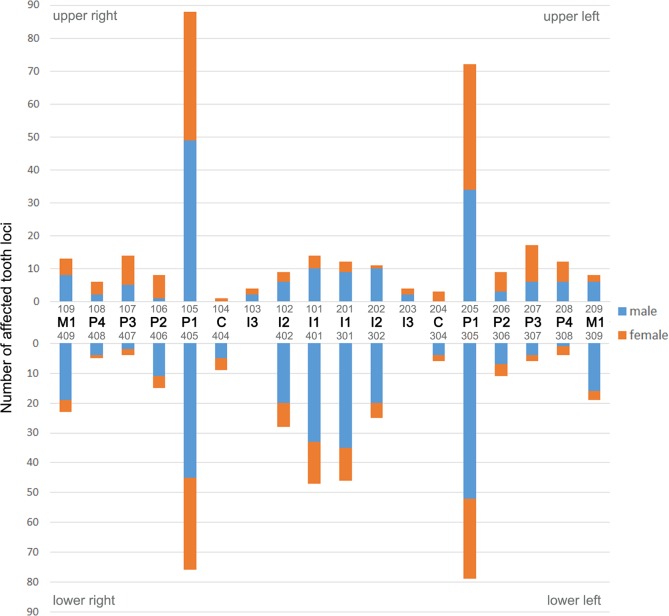
Distribution of intravital tooth loss in the study sample of Eastern Atlantic harbor seals (Phoca vitulina vitulina).Absolute numbers for the different tooth loci are given. The teeth are identified both by anatomical terms and the numbering of the modified Triadan system (see Fig 1).